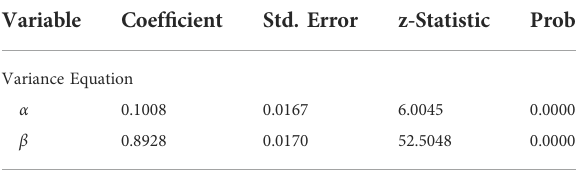
TABLE 16 Parameter estimates of the GARCH (1, 1) model for EUA futures returns in phase II without structural breaks from 2 January 2008, to 31 December 2012. Variable